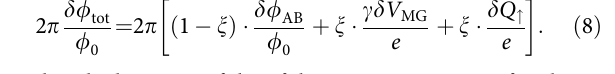
Fig. 5e–g (blue) and results in a conductance depicted in Fig. 5h